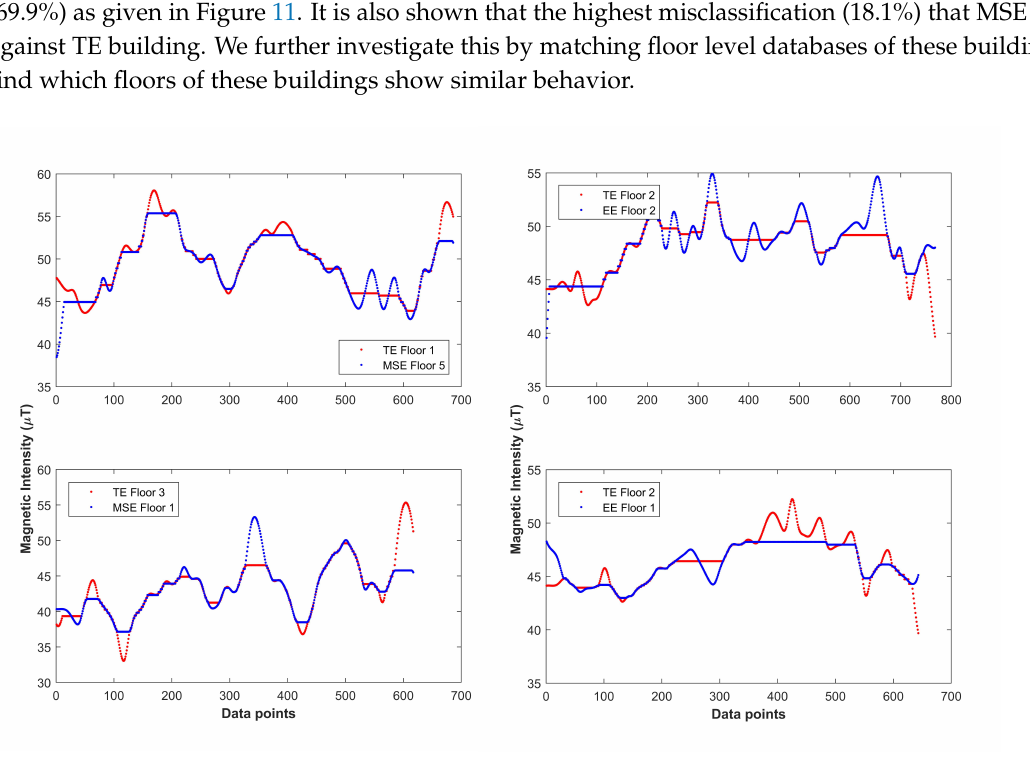
Figure 12. Aligned databases of MSE and TE buildings ( a ); and Aligned databases of TE and EE buildings ( b